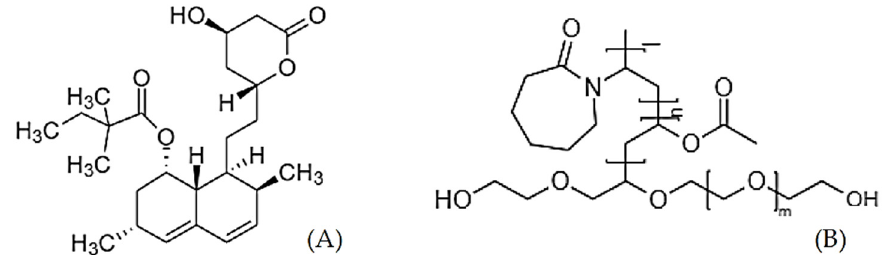
Figure 1. The structure of Simvastatin ( A ) and Soluplus ( B ).